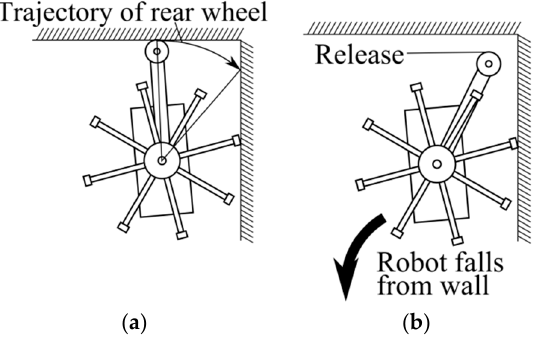
Figure 6. Robot falling from the right-angled route. ( a ) Rear wheel touching ceiling; ( b ) rear wheel releasing ceiling.